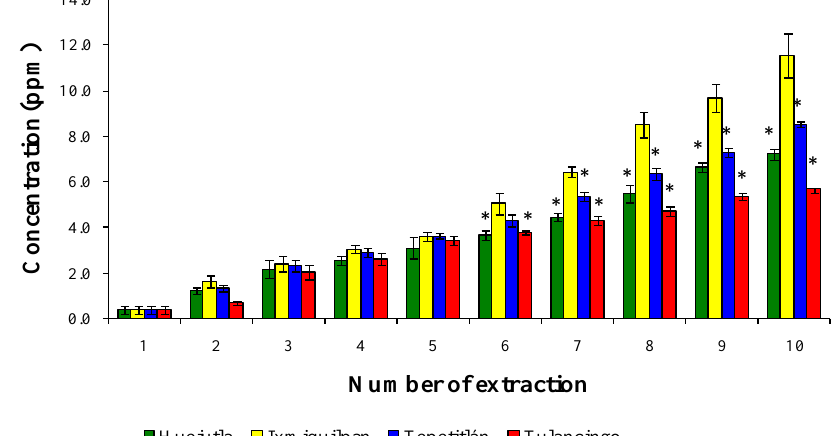
Figure 4. Concentration of Cd leached from the glass-clay containers into the chickpea puree. The bars show the mean values of the four regions with their standard deviations. * Indicates significant statistical differences with respect to the Ixmiquilpan region, which represents the highest concentration of the metal; p ≤